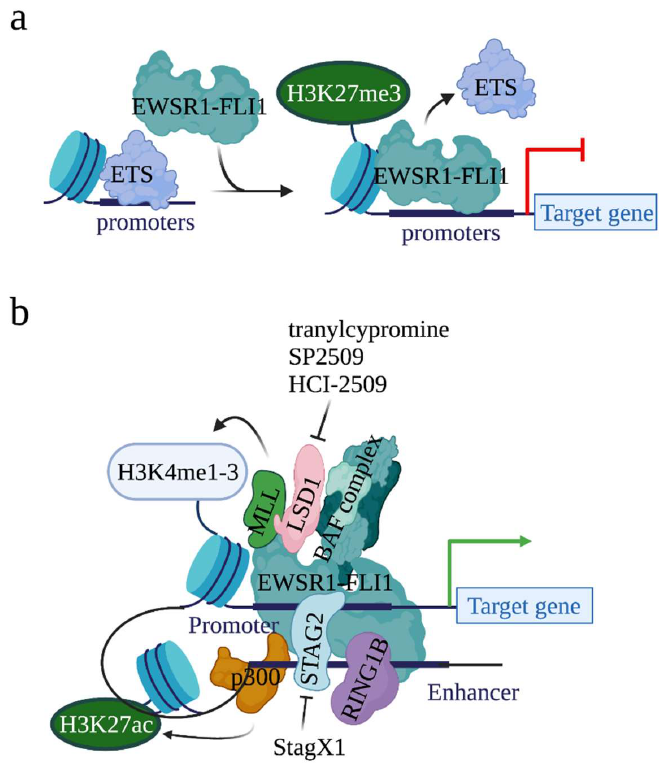
Figure 2. Model of EWSR1-FLI1 in modifying gene expression. ( a ) at the canonical ETS binding sites, in the presence of EWSR1-FLI1, EWSR1-FLI1 displaces ETS transcription factor on the chromatin to repress gene expression; ( b ) STAG2 establishes an enhancer/promoter loop on chromatin. At the enhancer regions, EWSR1-FLI1 interacts with acetyltransferase p300 to establish open chromatin state. RING1B, a catalytic component of the Polycomb-repressive complex 1 (PRC1), also interacts with EWSR1-FLI1 at the enhancers. It should be noted that, when interacting with EWSR1-FLI1, RING1B switches from a transcription repressor to a transcription activator. At the promoter re- gions, EWSR1-FLI1 recruits histone modifiers MLL, LSD1, BAF complex to establish open chroma- tin state to initiate gene transcription. Small molecule tranylcypromine, SP2509, and HCI-2509 can be used to target LSD1. Small molecule StagX1 was identified to treat EwS possessing mutant STAG2 by targeting mutant STAG2. 2.3. EWSR1-FLI1 Establishes Open Chromatin State at GGAA Microsatellites To map chromatin context that are EWSR1-FLI1, Riggi et al., compared the EWSR1- FLI1 binding sites with four histone modifications H3K4me1, H3K4me2, H3K4me3, and H3K27ac using ChIP-seq [21]. They found that the majority of EWSR1-FLI1 binding sites display H3K4me1, a ubiquitous marker of cis-regulatory elements, and H3K27ac, a more specific marker of enhancer activation. In addition, all promoters bound by EWSR1-FLI1 harbor H3K4me3, a marker of transcriptional initiation. These observations indicate that EWSR1-FLI1 binds cis-regulatory elements to regulate gene expression. To investigate the underlying regulatory mechanism of how EWSR1-FLI1 alters epi- genetic states, Tomazou et al., mapped the epigenome in a cellular model that is depend- ent on EWSR1-FLI1 and compared the epigenome states of EWSR1-FLI1-high and EWSR1-FLI1-low EwS cells [22]. In this study, the authors analyzed the DNA methylation using bisulfite sequencing, checked the histone modifications (H3K4me3, H3K4me1, H3K27ac, H3K56ac, H3K36me, H3K27me3, and H3K9me3) using ChIP-seq, measured the open chromatin status using ATAC-seq, and identified the transcription changes using RNA-seq. They found that EWSR1-FLI1 binding is associated with reduced DNA methyl- ation, opened chromatin, depleted nucleosome, and elevated gene expression. These